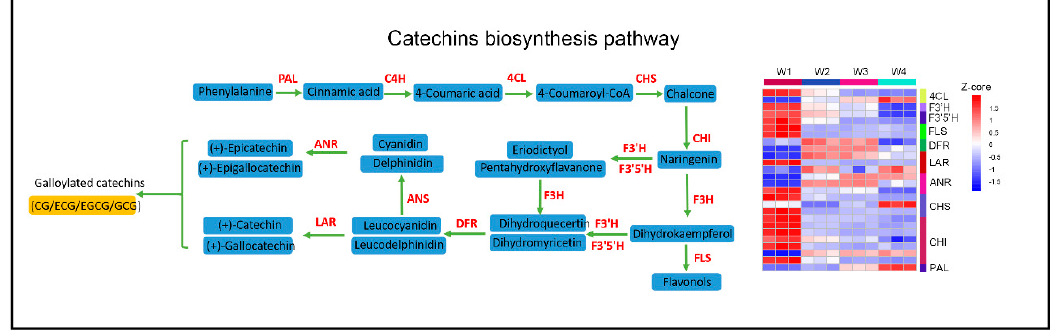
Figure 5. E ff ect of withering on the catechin biosynthesis pathway in tea leaves. A simplified model of Figure 5. Effect of withering on the catechin biosynthesis pathway in tea leaves. A the catechin biosynthesis pathway in tea plants (left) and a heat map, showing the expression pattern simplified model of the catechin biosynthesis pathway in tea plants (left) and a heat map, of related DEGs based on the Z-core value at di ff erent timepoints during the withering process. The DEGs were strictly filtrated by | log2 (fold change) | ≥ 2 and p value < 0.05, with at least one of three comparisons (W2 vs. W1, W3 vs. W1, and W4 vs. W1). Blue represents a low expression level, and red represents a high expression